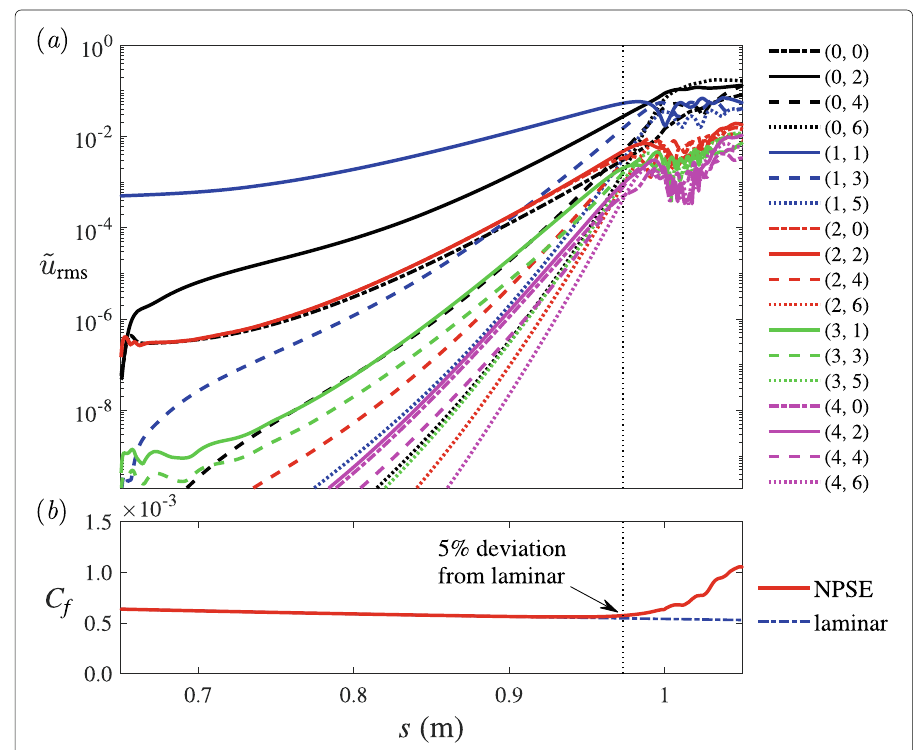
Fig. 7 Streamwise development of ( a ) the amplitudes of multiple waves and ( b ) the averaged skin friction in the oblique-mode breakdown with f = 500kHz and k c =